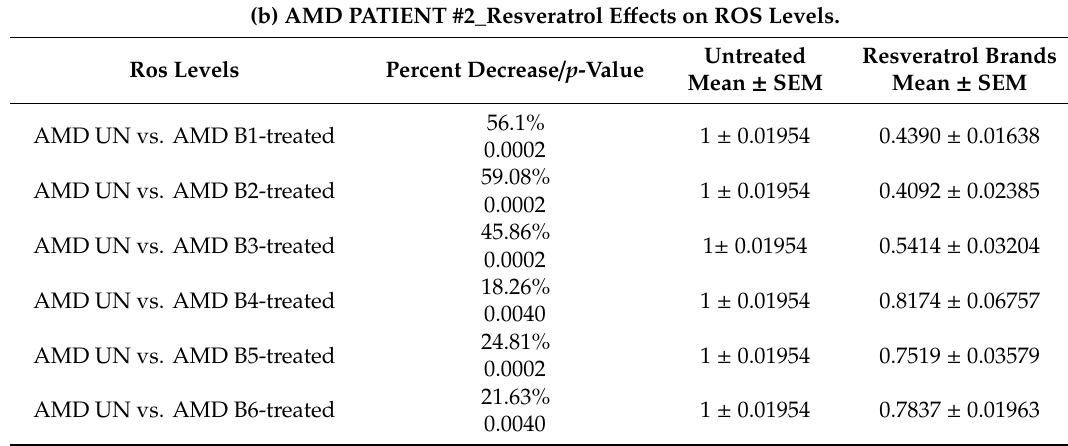
Figure 4. Effects of resveratrol formulations on cell viability ( A ) and ROS levels ( B ) in AMD patient